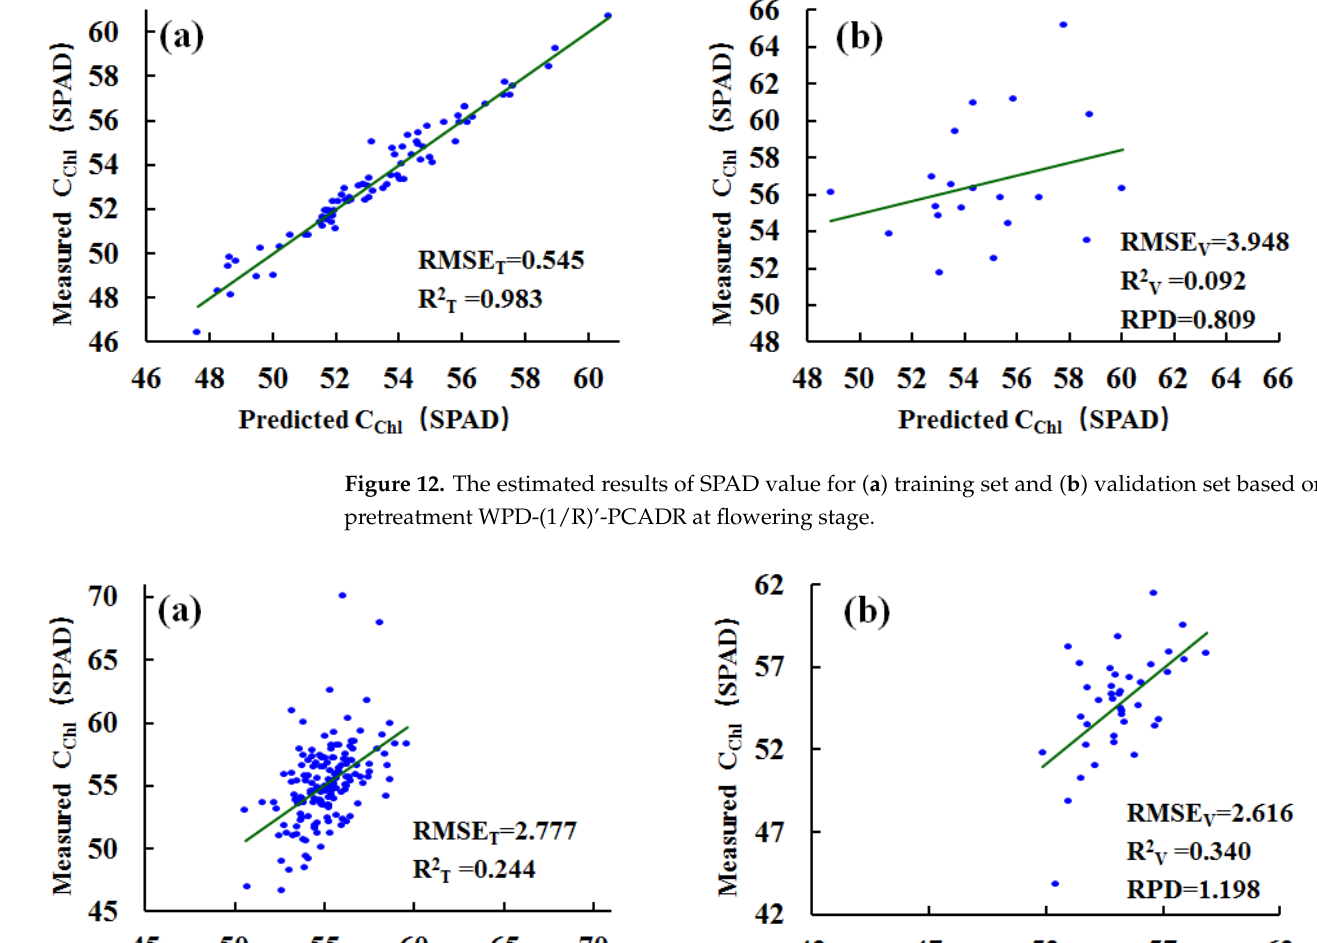
Figure 11. The estimated results of SPAD value for ( a ) training set and ( b ) validation set based on pretreatment WPD-1/R-PCADR at heading stage.